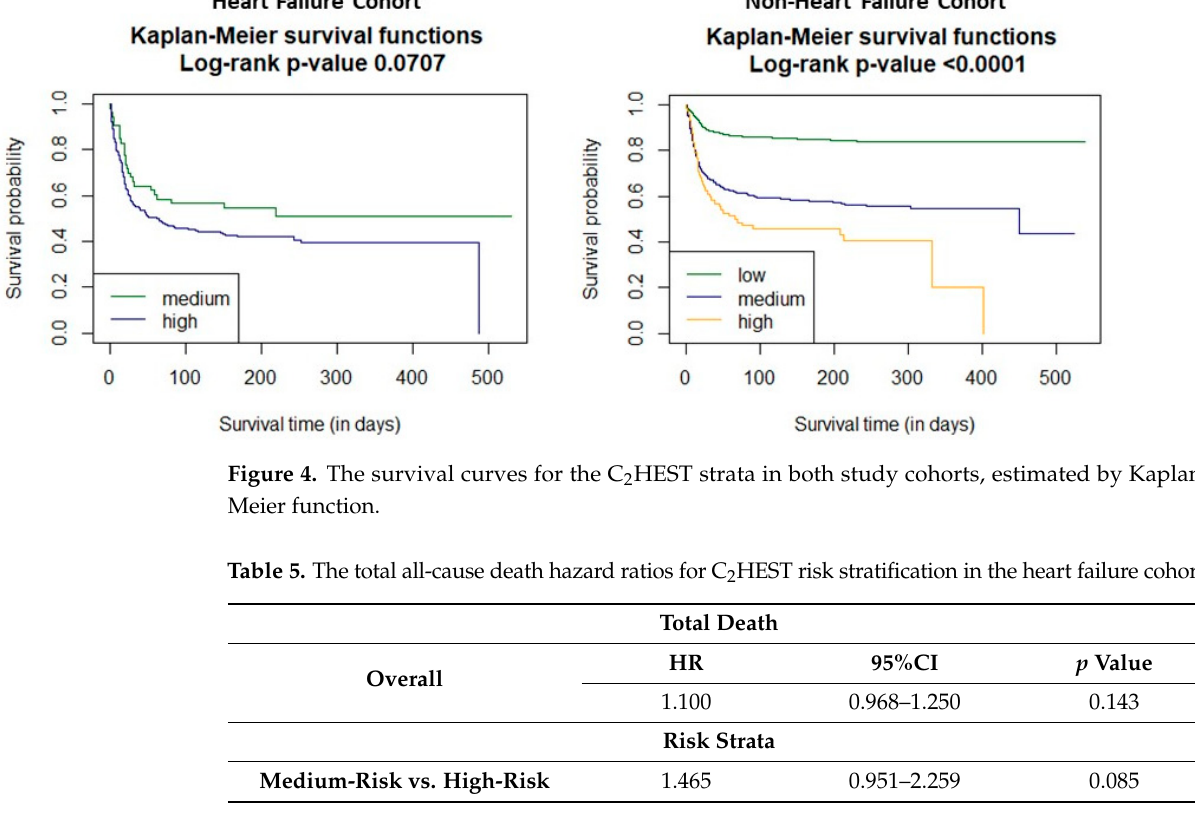
Figure 3. Time-dependent ROC analysis for the C 2 HEST predictive abilities of all-cause death in both study cohorts.